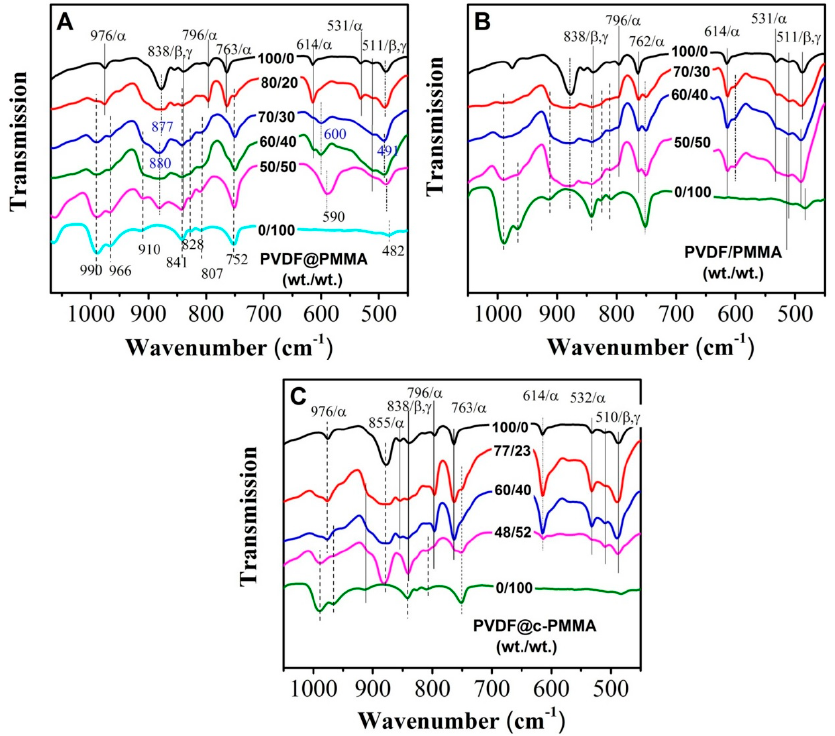
Figure 7. Fourier transform infrared spectroscopy (FTIR) profiles of three series of the samples: ( A ) PVDF@PMMA; ( B ) PVDF/PMMA; and ( C ) PVDF@c–PMMA, at various weight ratios.